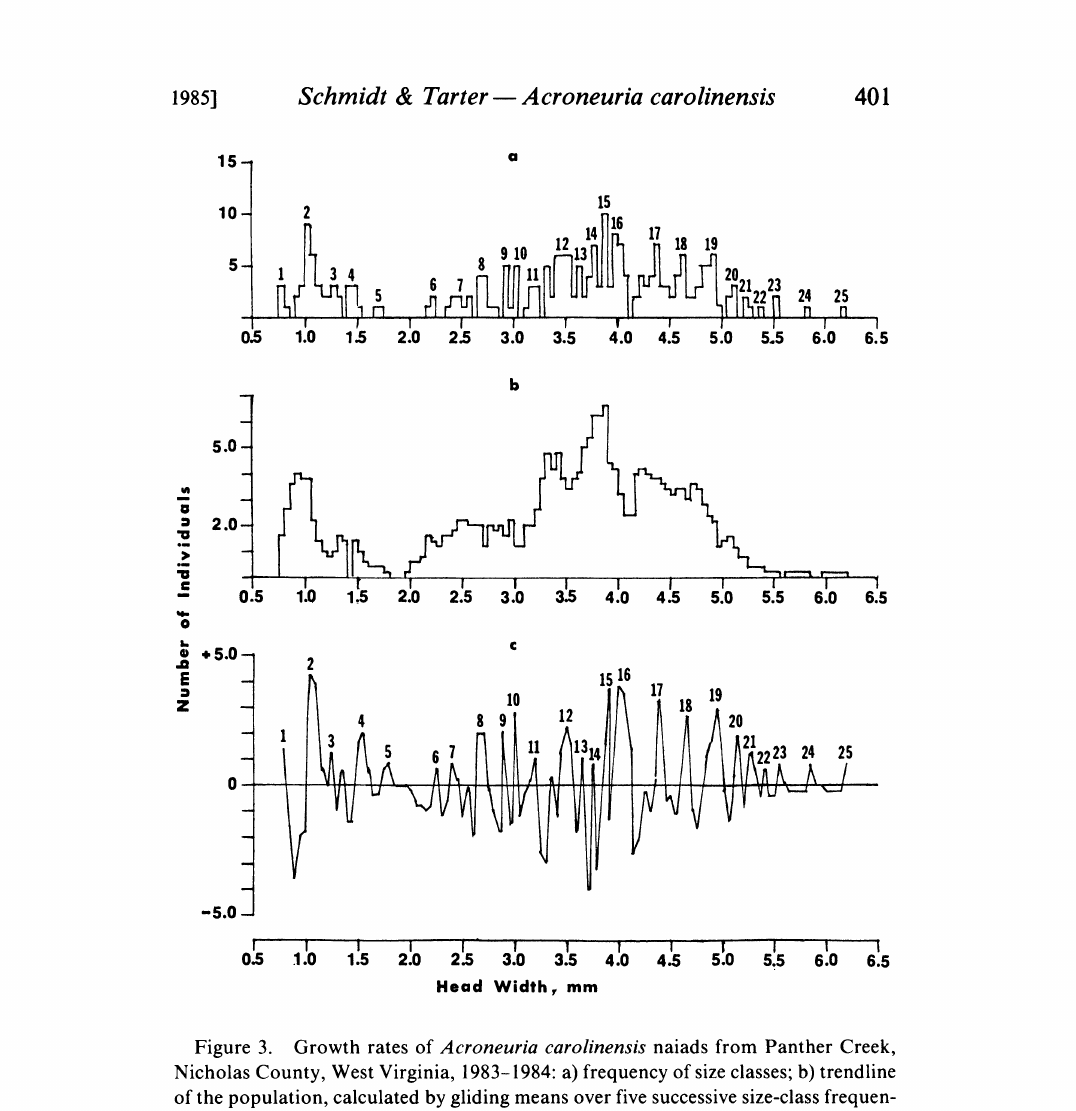
Figure 3. Growth rates of Acroneuria carolinensis naiads from Panther Creek, Nicholas County, West Virginia, 1983-1984: a) frequency of size classes; b) trendline of the population, calculated by gliding means over five successive size-class frequen- cies at a time; c) periodicity of maximum frequency of